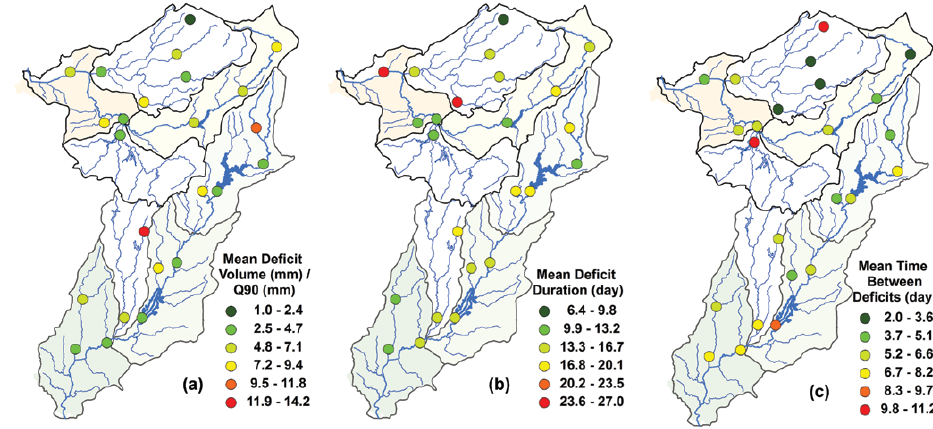
Fig. 11. Relative deficit (a) , mean deficit duration (b) , and average time between deficits (c) for both watersheds.